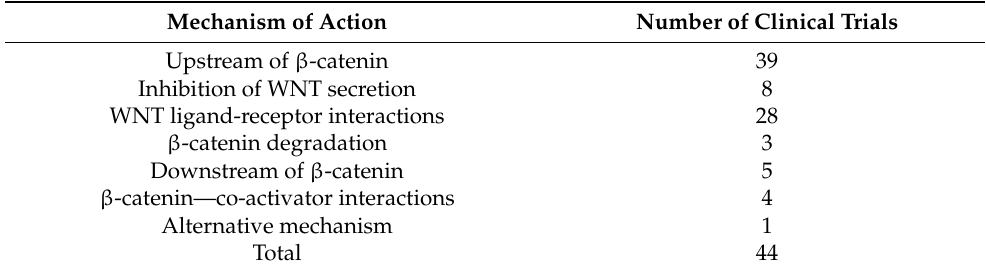
Table 3. Different therapeutic strategies performed in clinical trials to inhibit the WNT signaling